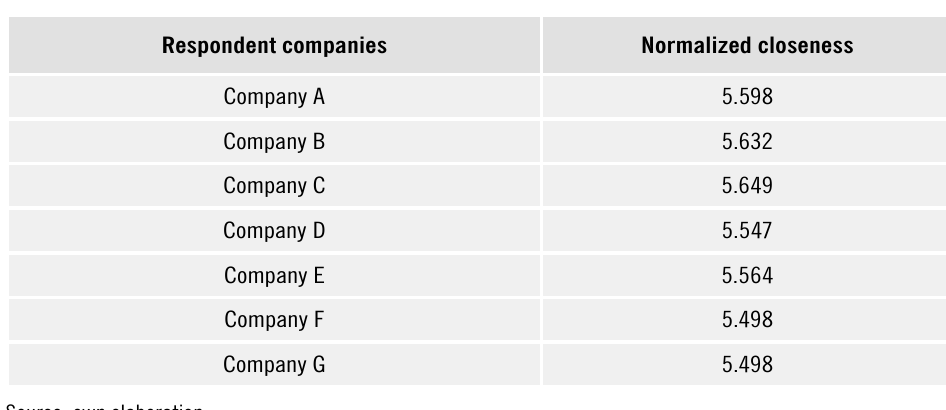
Table 13. Normalized closeness parameters of the respondent companies with weighted relations